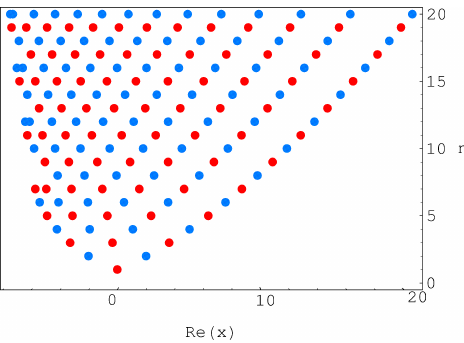
Fig. 5. Real zeros of B n .x;(cid:21)/ for 1 (cid:20) n (cid:20) 20